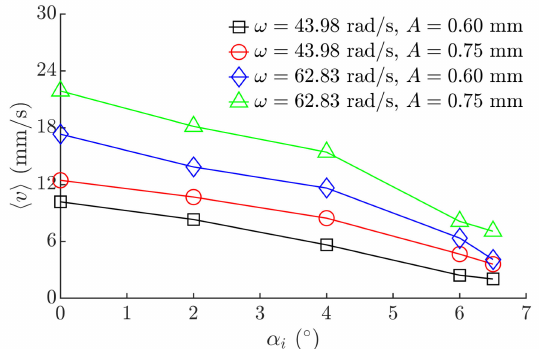
Figure 9. Average velocity vs. the angle of inclination of the platform when φ = π /6, λ = 4.1 π